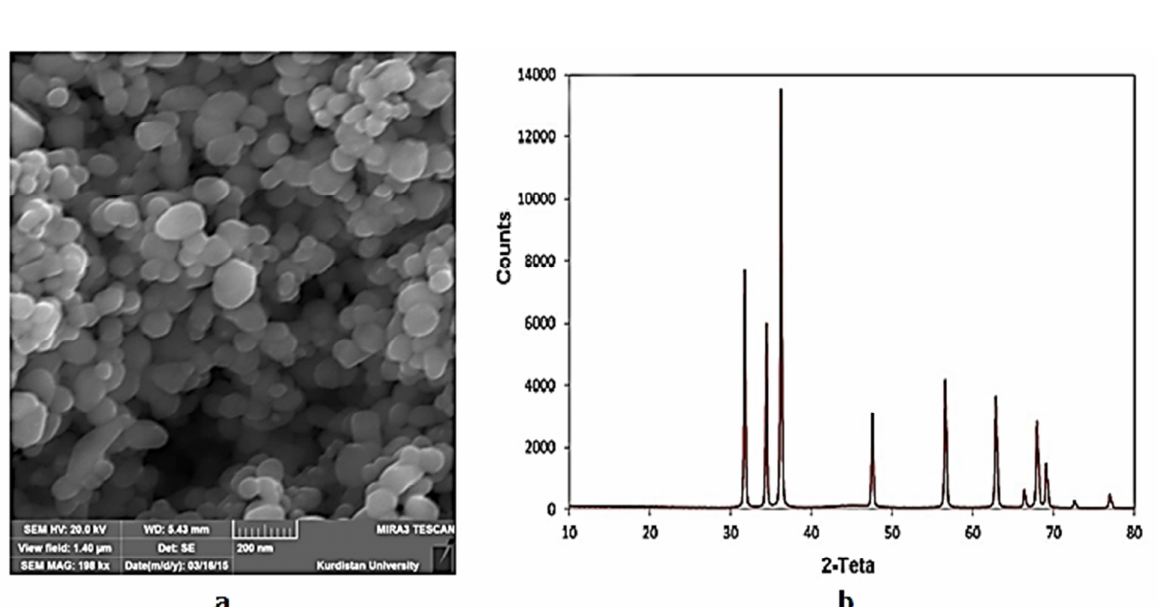
Figure 1. Scanning electron microscopy (SEM) images with 198 k × MAG (a) and X-ray diffraction (XRD) pattern of ZnO nanostructures (b)